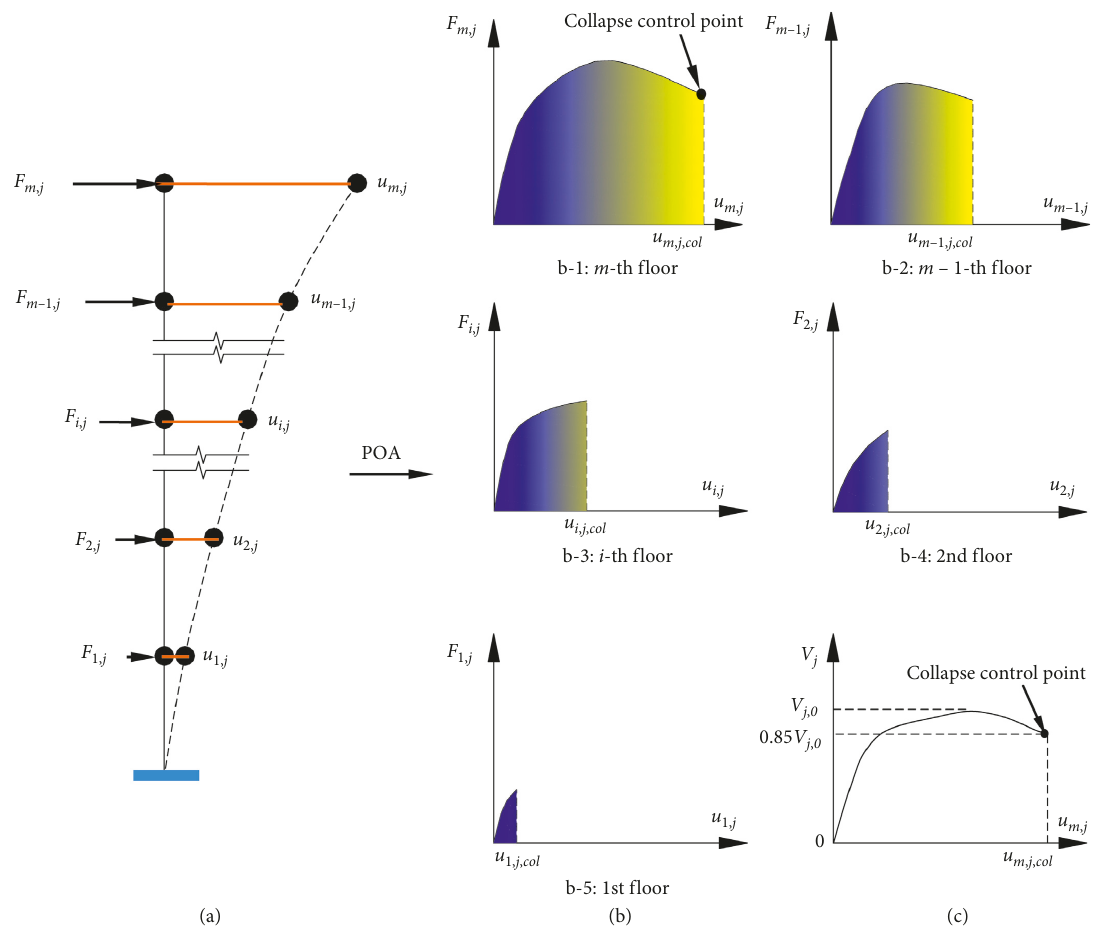
Figure 1: Structural elastic-plastic strain energy based on pushover analysis. (a) Pushover analysis model. (b) Lateral force-floor dis- placement curve. (c) Bottom shear-top lateral displacement